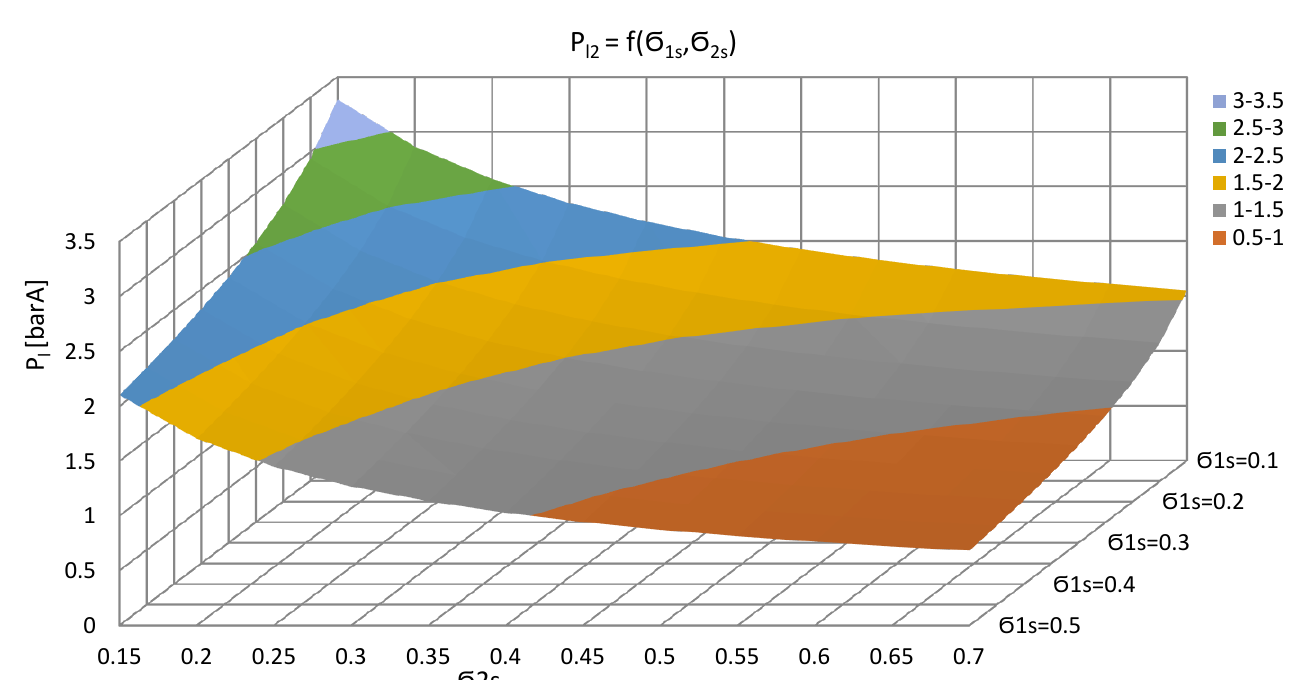
Figure 5. Relation of the steam pressure on the outlet from the two-stage injector unit driven by steam bleads 3.0 and 10 barA in the function of ejection ratio P l 2 = f ( σ 1 s , σ 2 s ) .